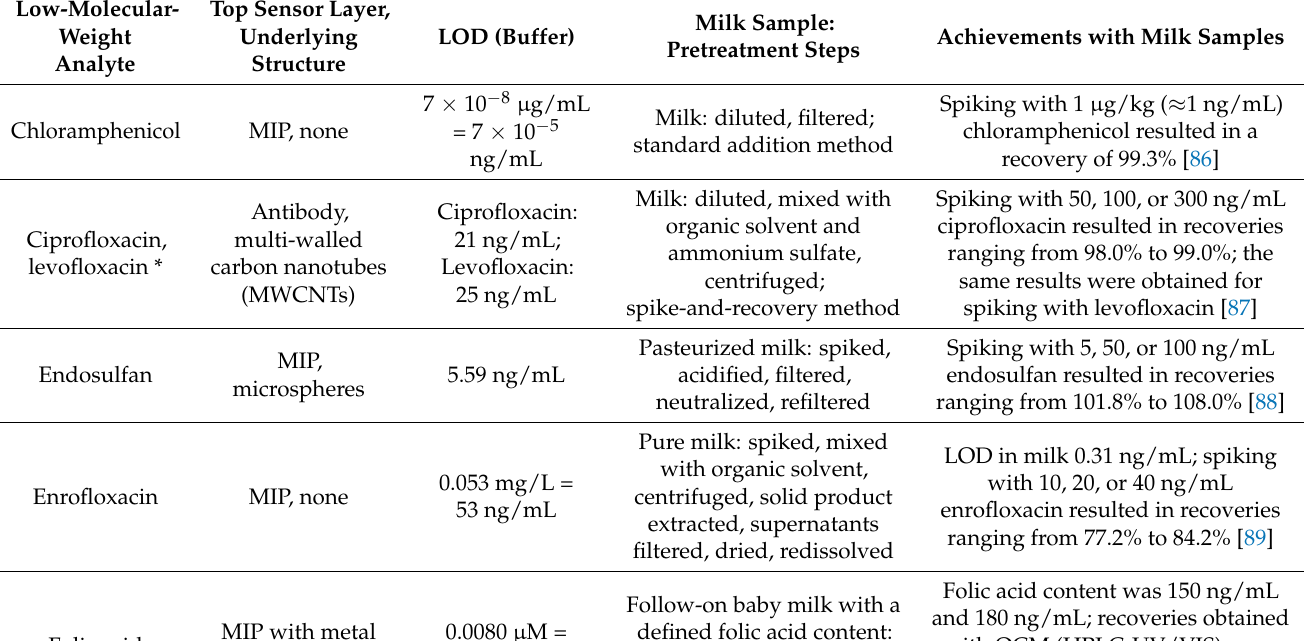
Table 2. Direct detection of low-molecular-weight compounds ( M r < 500) in cow’s milk with QCM